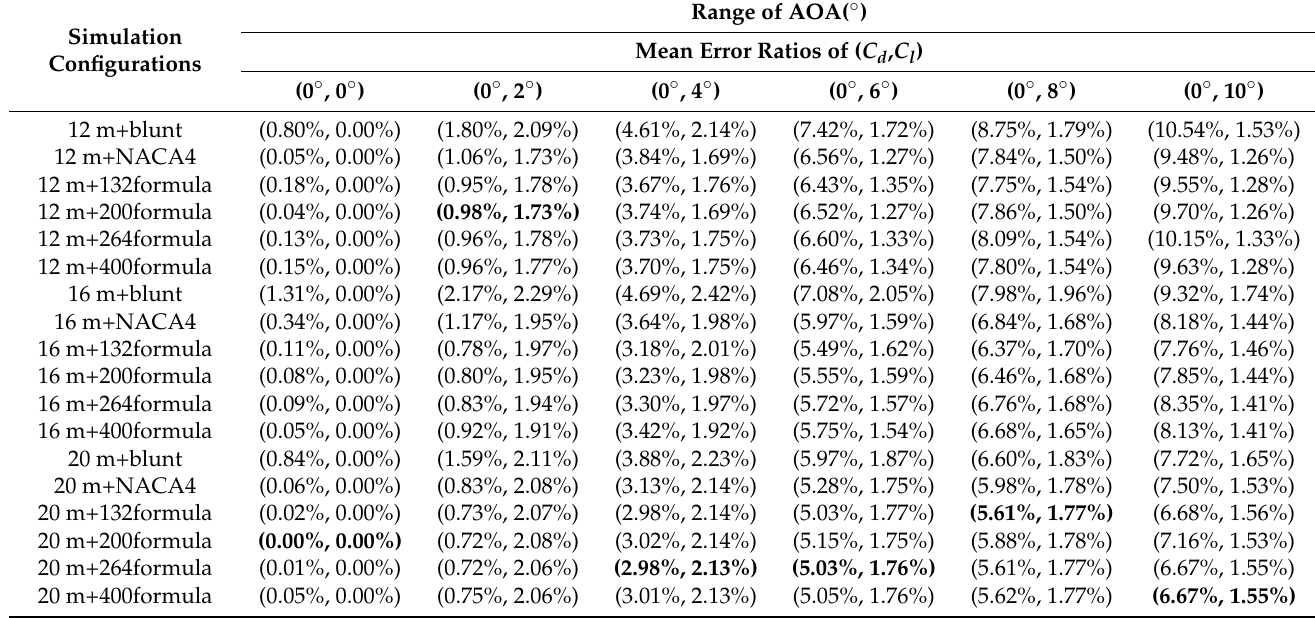
Table 18. The mean error ratios of C d and C l of Spalart–Allmaras turbulence